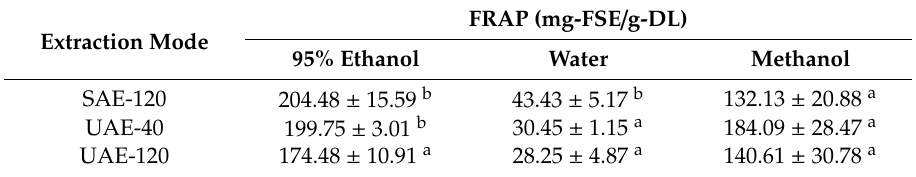
Table 2. Comparison of SAE and UAE for FRAP using 95% ethanol, water, and methanol. Extraction